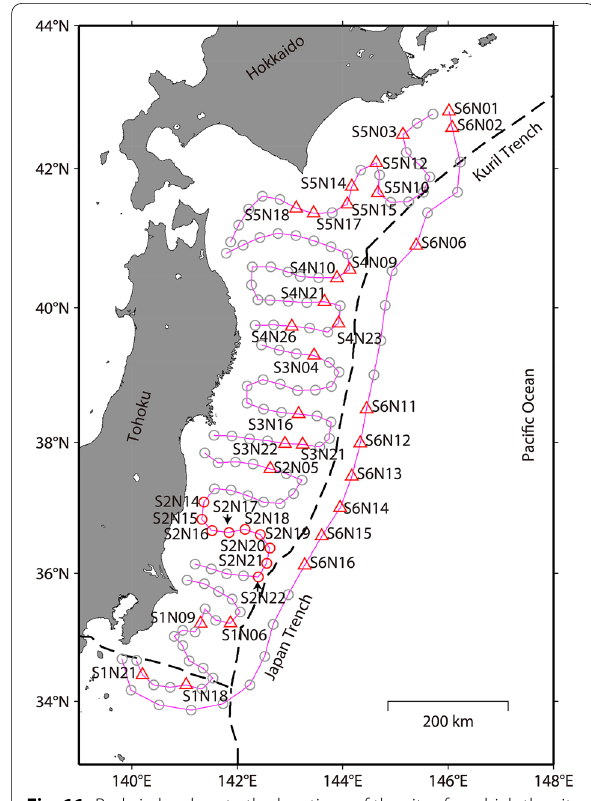
Fig. 11 Red circles denote the locations of the sites for which the site spectra are plotted in Fig. 12. The site codes are written near the site symbols. Red triangles denote the locations of the sites, where the site spectra at higher frequencies were spurious (see Fig.